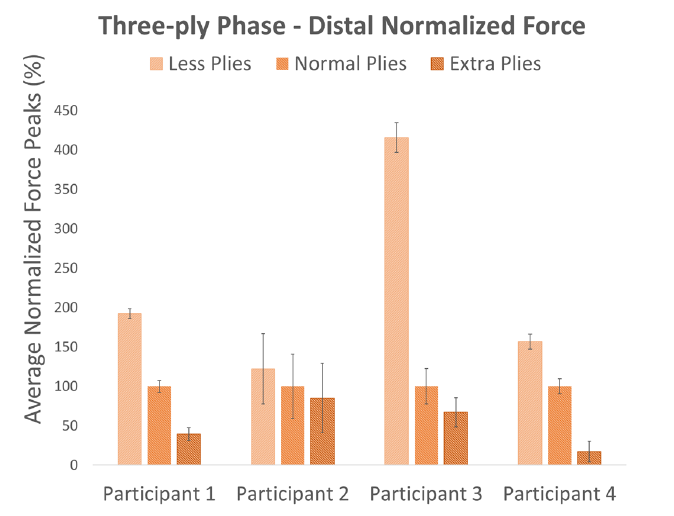
Figure 3. Results of the three-ply phase. Average peaks of normalized force in the distal location of the prosthetic sockets of the four participants in the three-ply